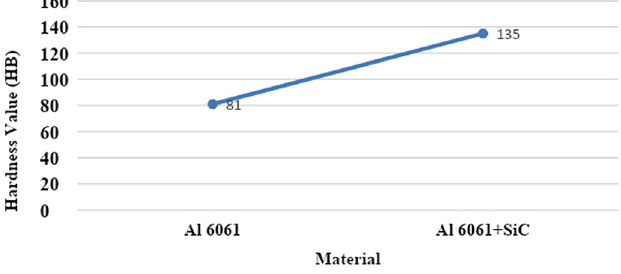
Fig. 4. Hardness of Al 6061 compared with Al6061+ SiC.